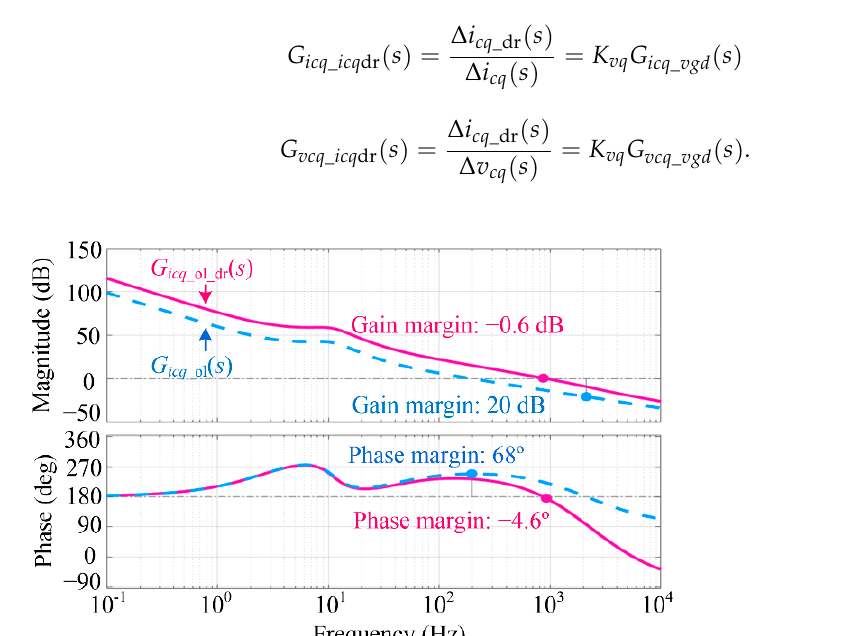
Figure 9. Pole-zero map of transfer functions with voltage droop: ( a ) G icd _cl_dr ( s ); ( b ) G icd ref_ icq _dr ( s ); ( c ) G icq ref_ icd _dr ( s ).